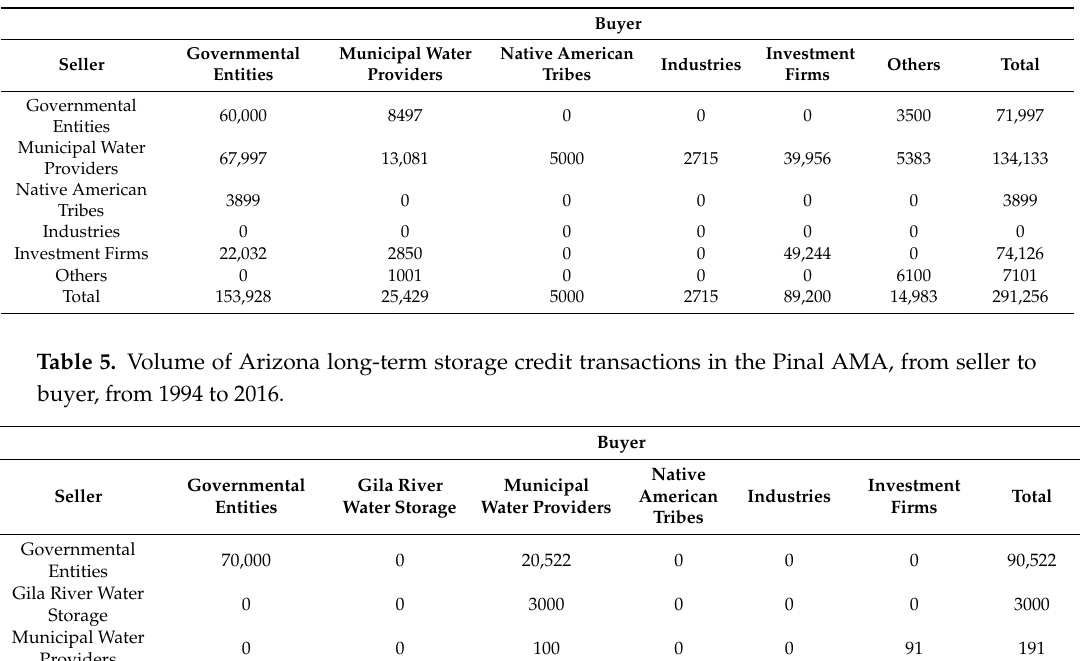
Table 4. Volume of Arizona long-term storage credit transactions in the Tucson AMA, from seller to buyer, from 1994 to 2016.